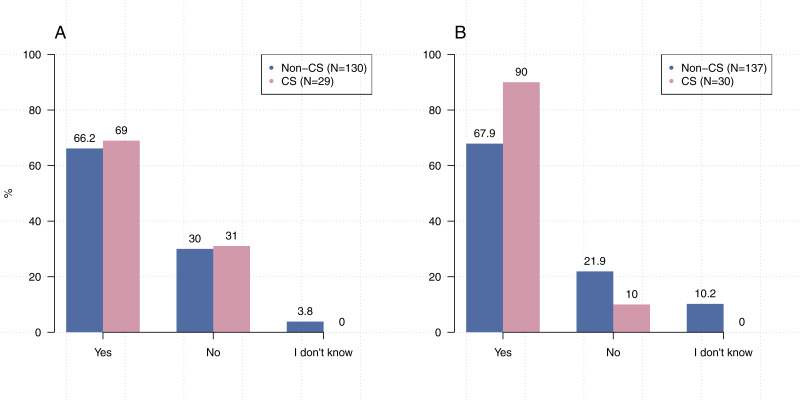
CS researchers tend to provide information about dependencies more than other disciplines.(A) When you share your code or software, do you share it alongside related files (e.g., datasets)? (B) When you share your code or software, do you provide information about dependencies?